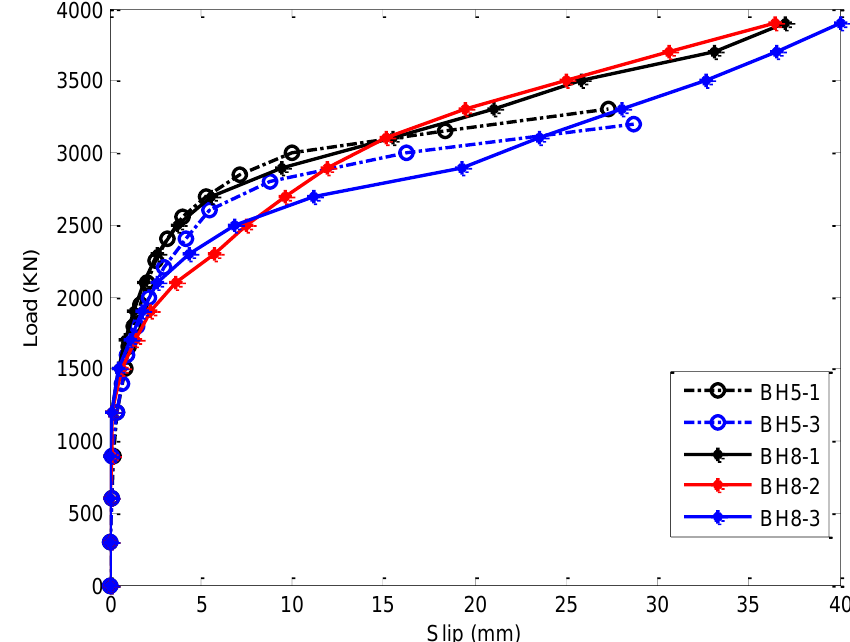
Figure 25. Load – slip relationship. Figure 25. Load–slip